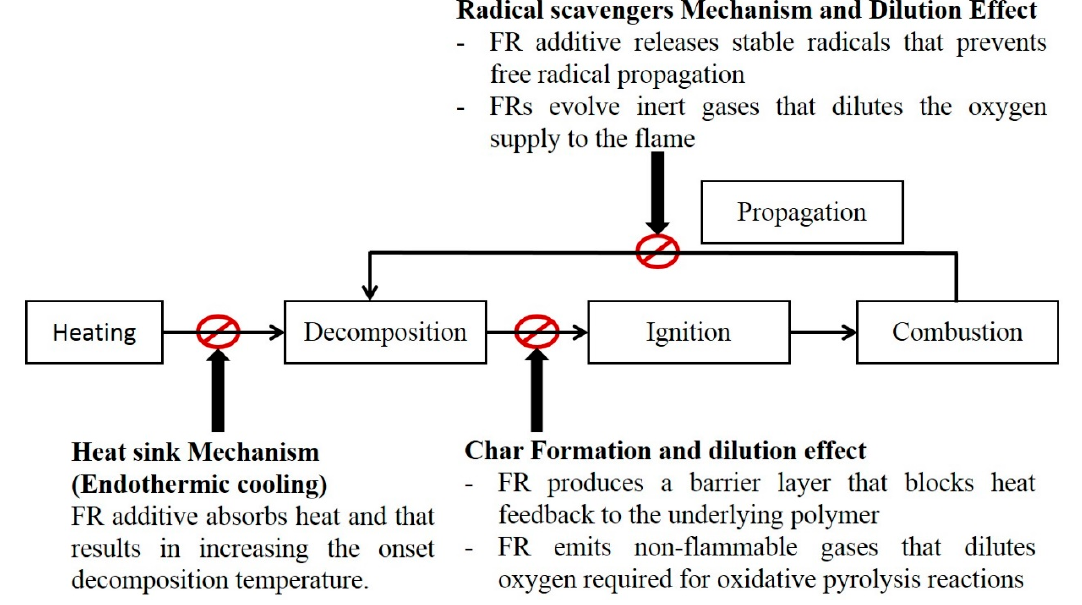
Figure 2. The main flame retardant mechanisms. Table 3. Examples of FRs and their mechanism of action.